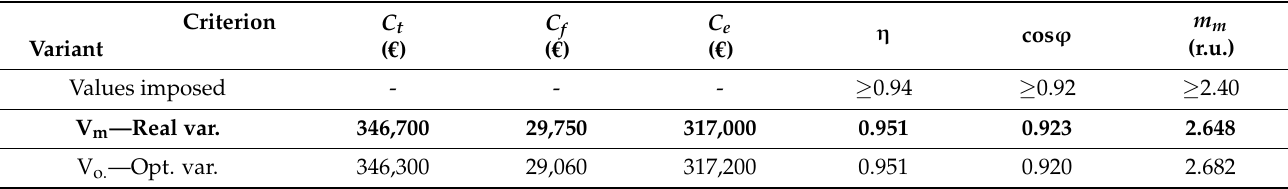
Table 2. The values obtained for the analyzed case.